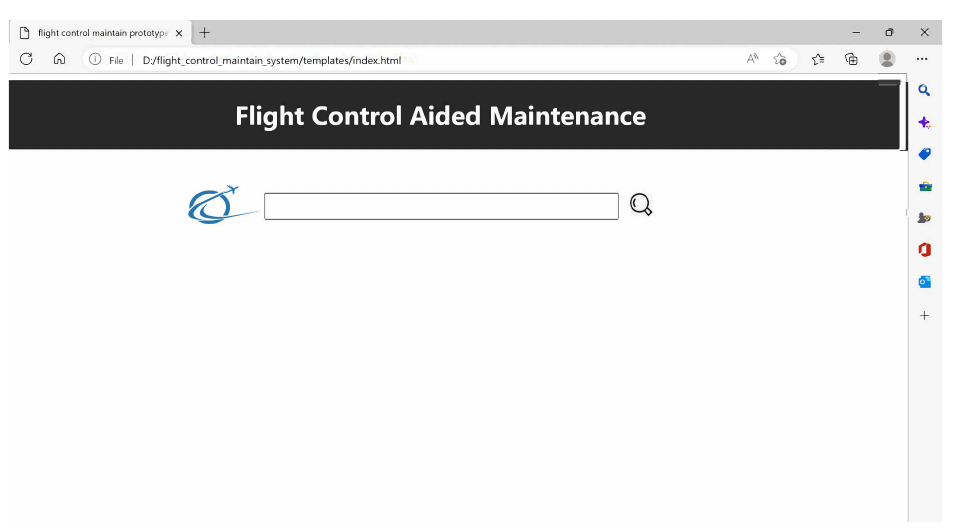
Figure 9. Main interface of flight control aided maintenance